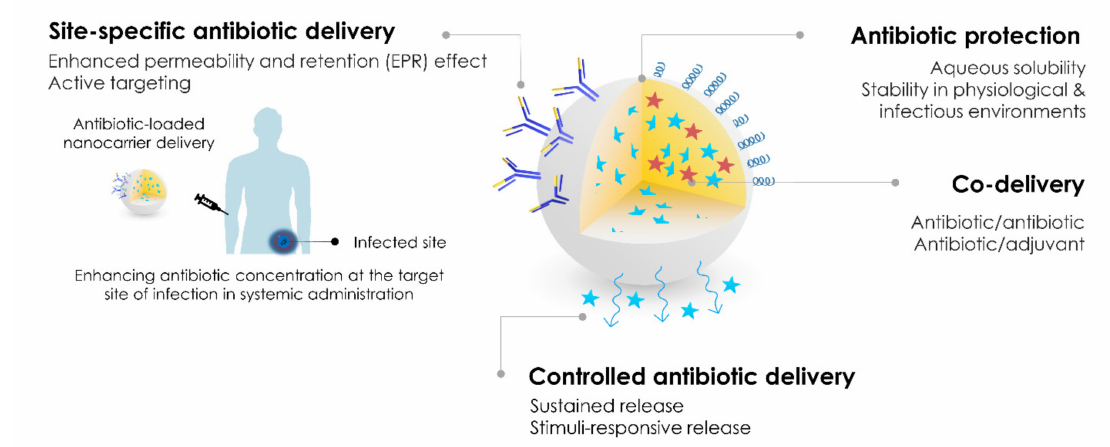
Figure 1. Overview highlighting the main advantages of a nanocarrier-based antibiotic delivery approach for the treatment of bacterial infections. Depending on the targeted therapeutic applications, nanocarriers may be engineered to improve different pharmacokinetic parameters of antibiotics, resulting in increased therapeutic efficacy and reduced adverse side